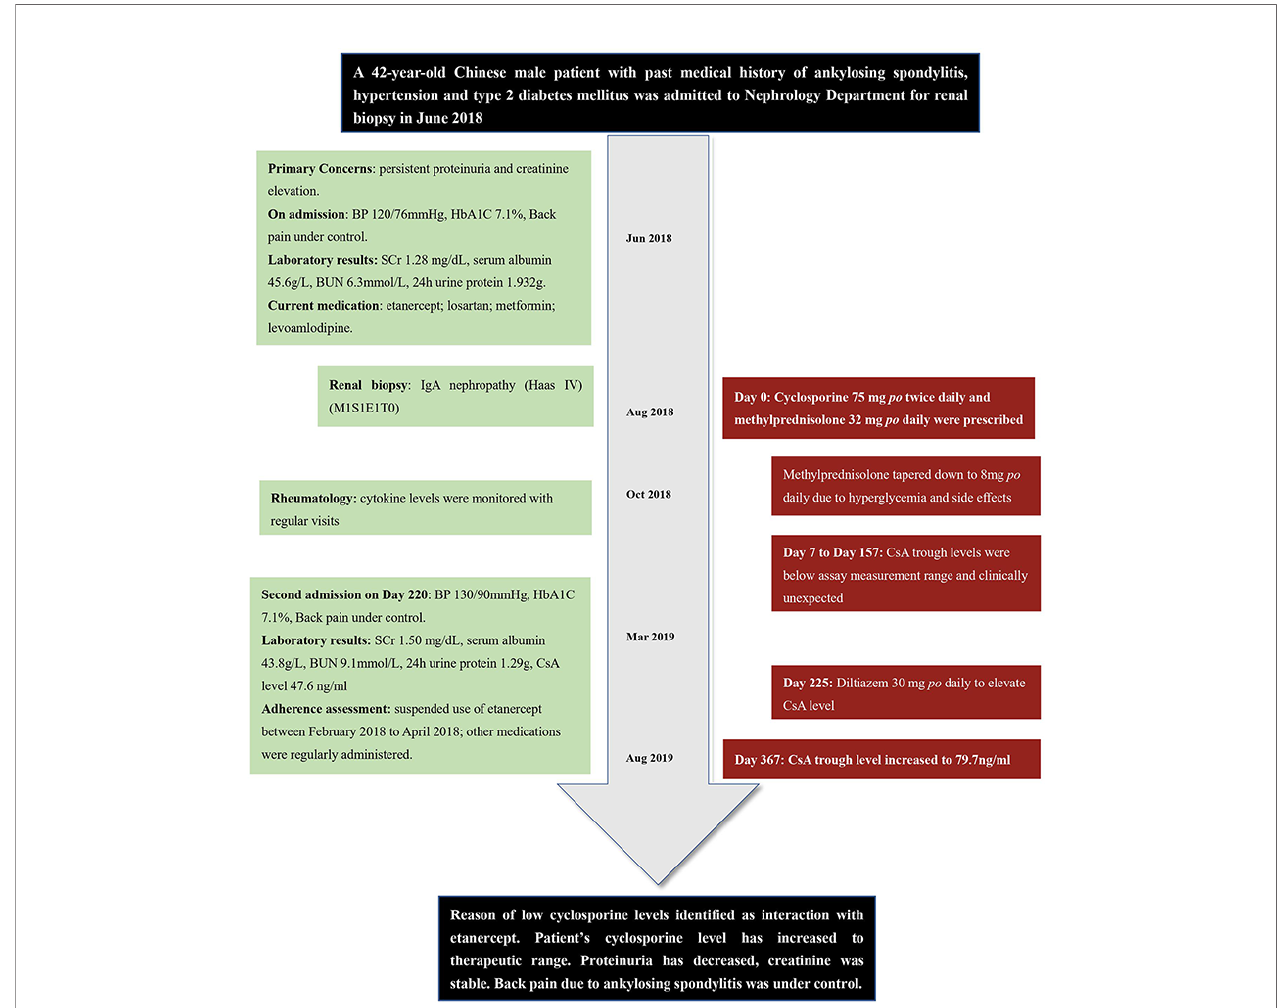
FIGURE 1 | Timeline of the presented case report. BP, blood pressure; SCr, serum creatinine; BUN, blood urea nitrogen; CsA,